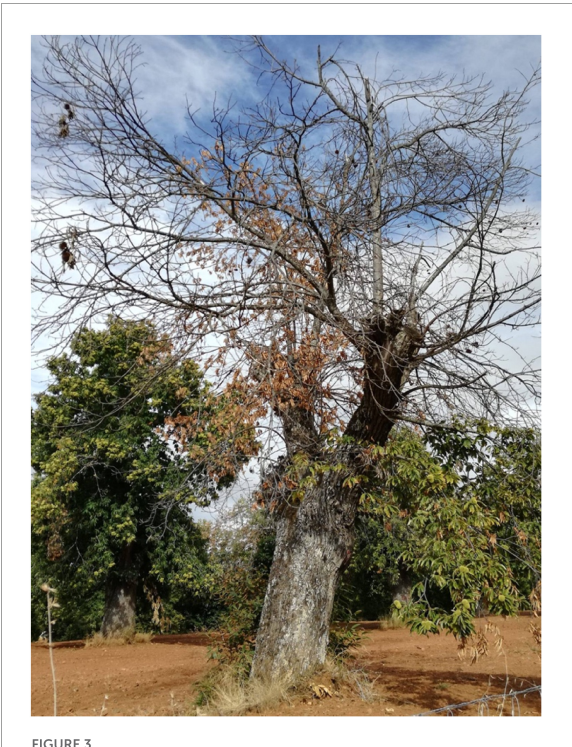
FIGURE3 Castanea sativa shows symptoms of ink disease such as discoloration of leaves and dieback of branches. This picture was taken in Bragança, Trás-os-Montes region,